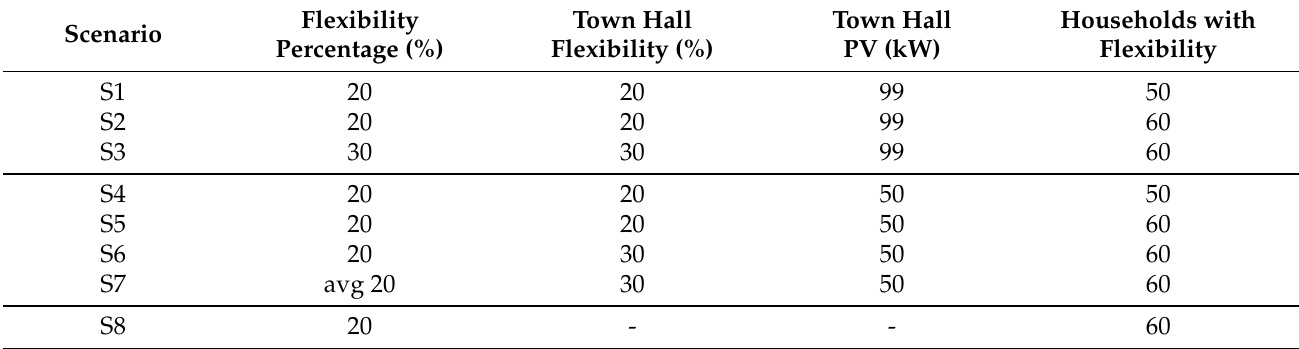
Table 2. The parameters of the various simulation